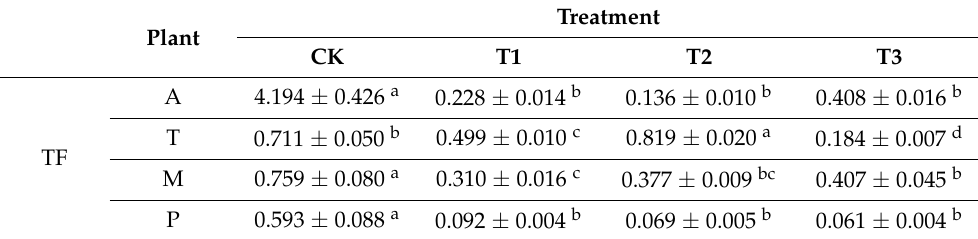
Table 3. Effects of Pb pollution level on lead